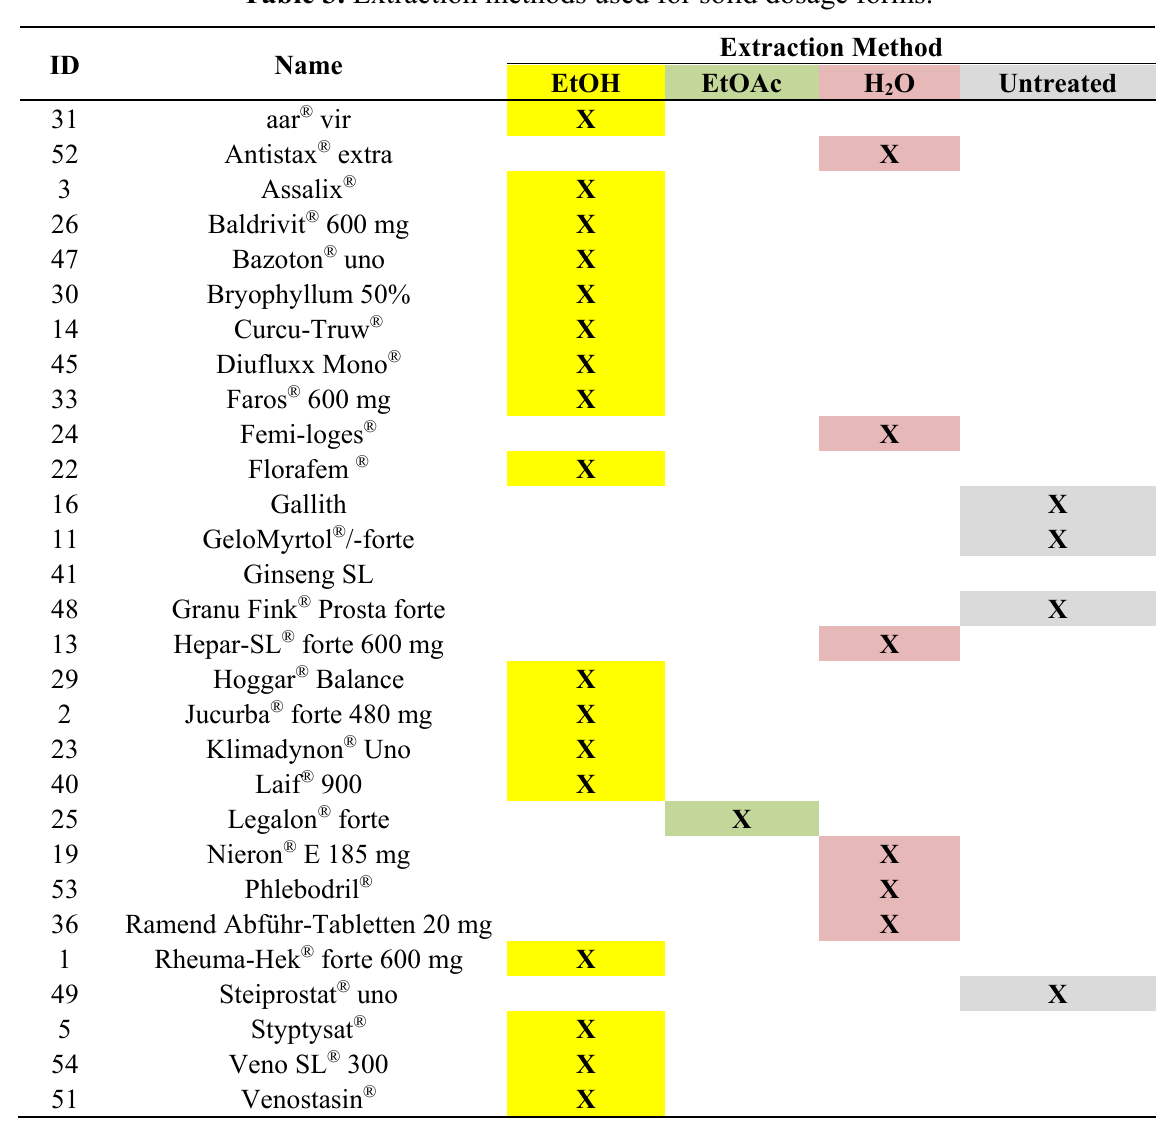
Table 3. Extraction methods used for solid dosage